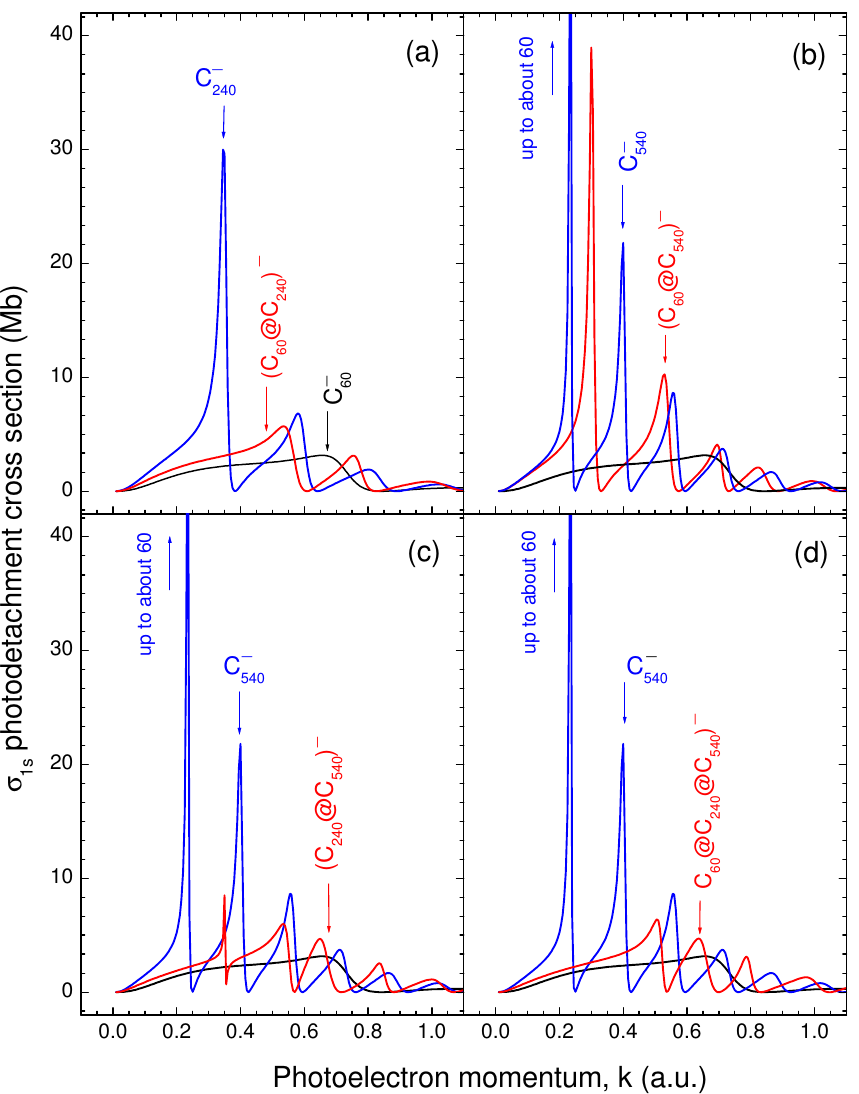
Figure 4. Calculated σ 1 s photodetachment cross sections of bare fullerene anions and nested fullerene onion-anions, as designated in the figure. Note, on all parts of the figure, the σ 1 s of C − by a